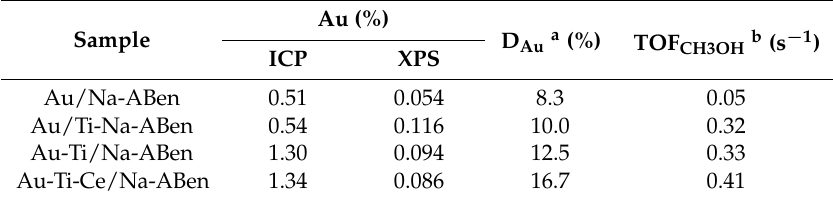
Table 1. The Au contents of the prepared samples measured by Inductively Coupled Plasma (ICP), X-ray photoelectron spectroscopy (XPS), D Au and TOF CH3OH .